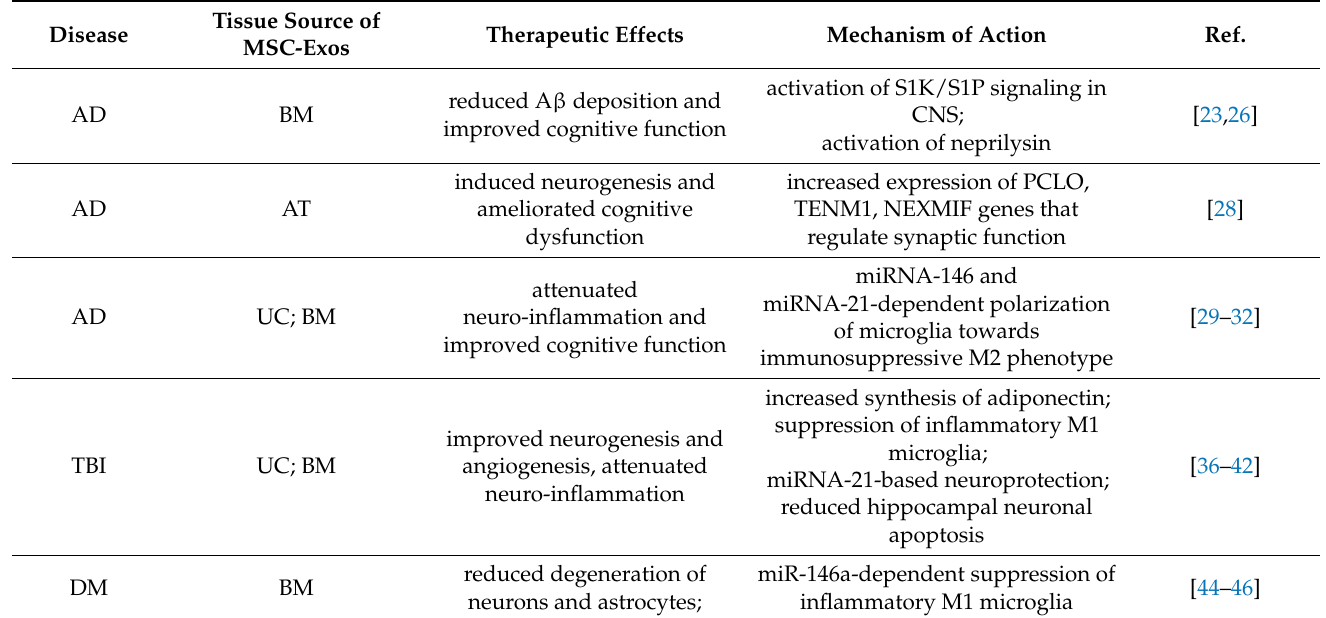
Table A1. Therapeutic effects of mesenchymal stem cell-derived exosomes in animal models of neurocognitive diseases. Tissue Source Disease